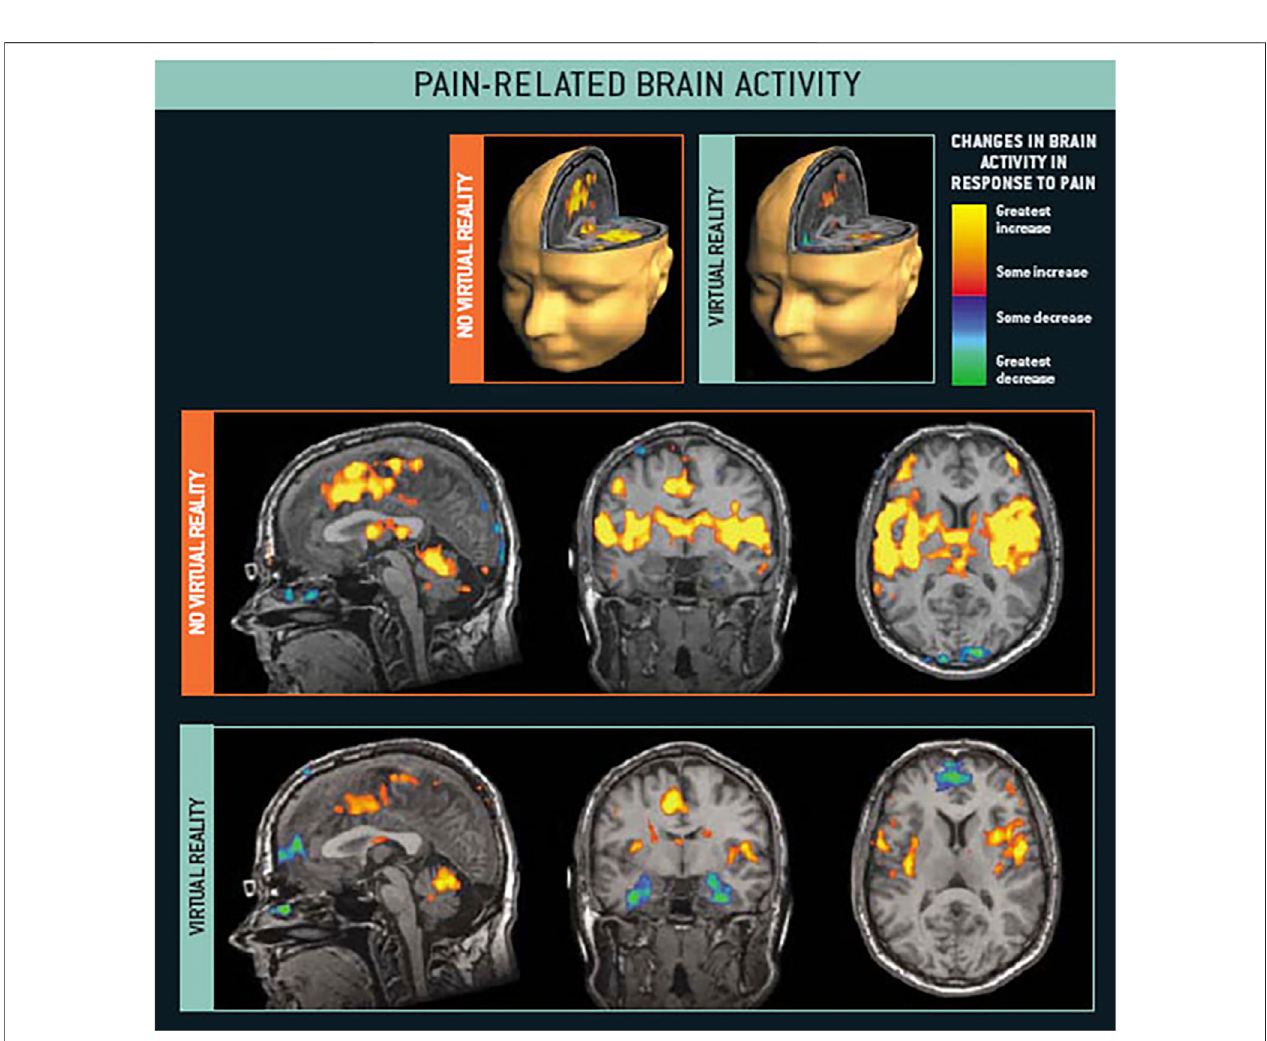
FIGURE3| fMRIbrainscansshowintensepainrelatedbrainactivityduringnoVR,andsigni fi cantreductionsinpain-relatedbrainactivityduringVR.Hoffmanetal., 2004. Images by Todd Richards and Aric Bills, copyright Hunter Hoffman, www.vrpain.com.